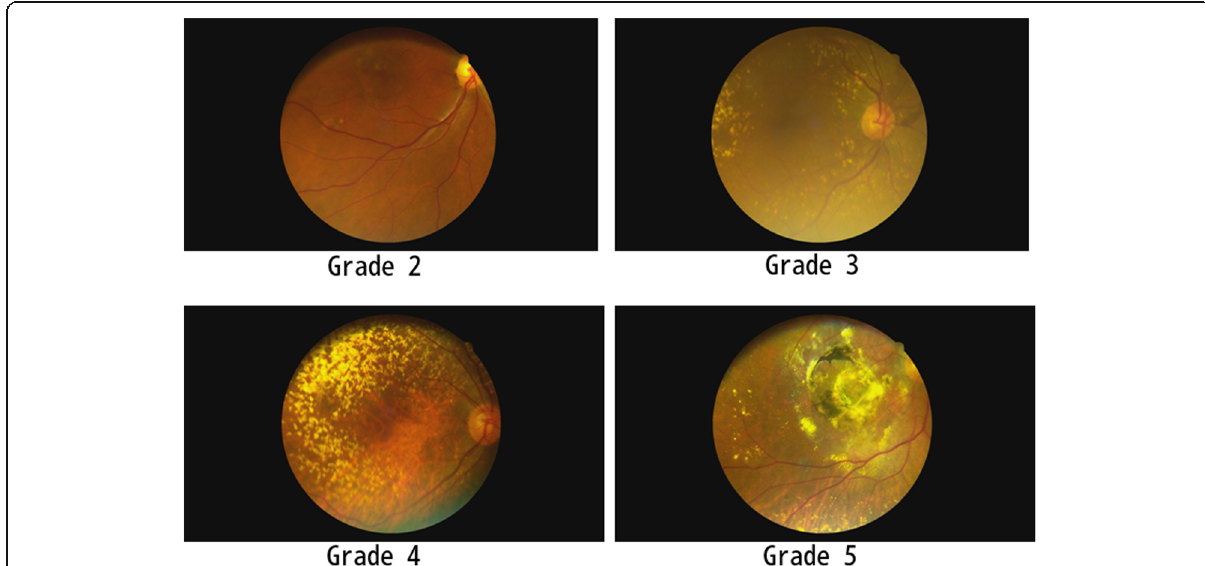
Fig. 1 the representative images of grade 2 to grade 5 AMDs from our patients